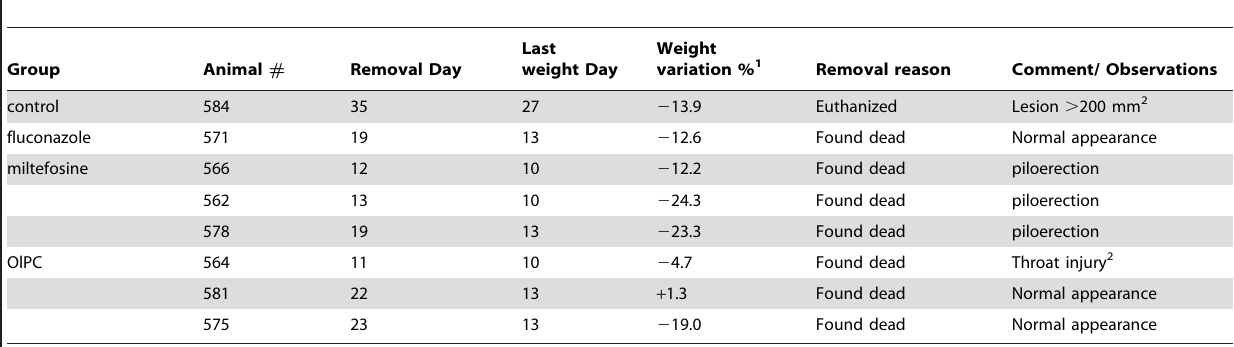
Table 3. Sacrifices and found dead animals during comparative efficacy of OlPC in L. major infected BALB/c mice up to Day 35 post treatment